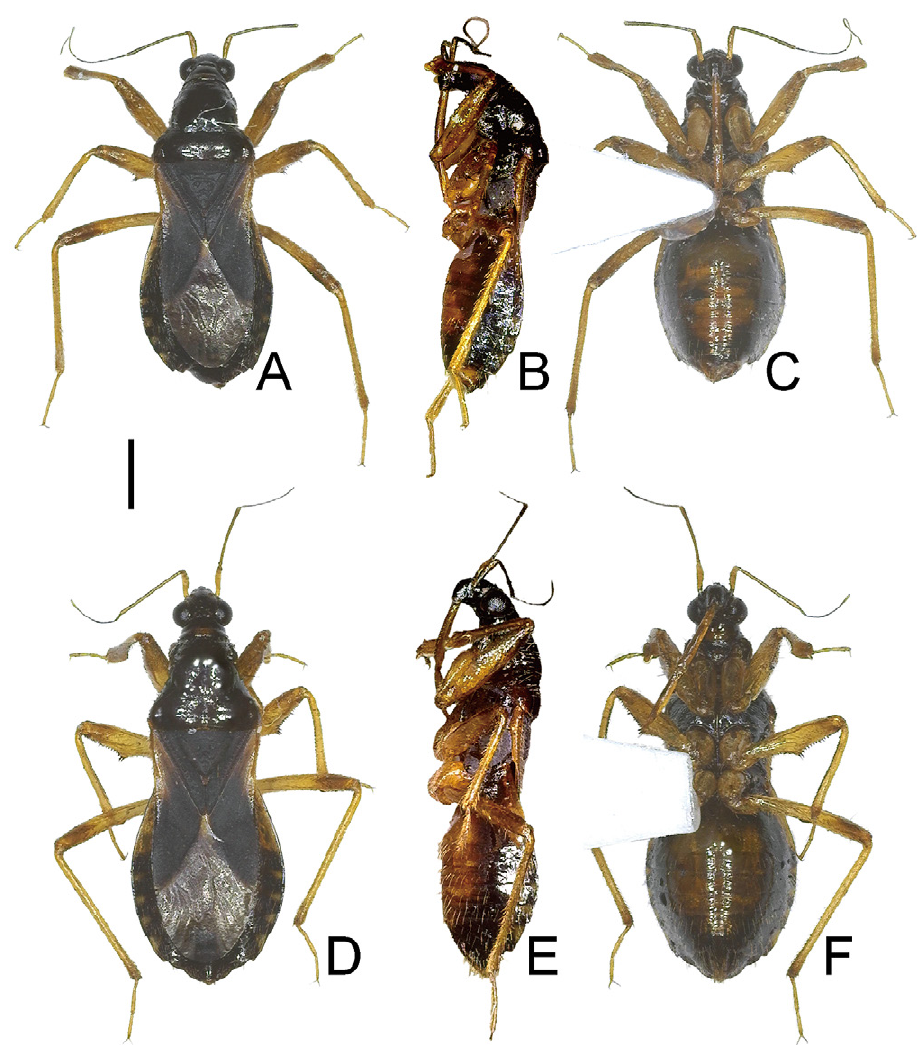
Figure 1. Dried specimens of Alloeorhynchus reinhardi from Fukuoka, Kyushu, Japan. A. Male, dorsal view. B. Male, lateral view. C. Male, ventral view. D. Female, dorsal view. E. Female, lateral view. F. Female, ventral view. Scale bar: 1.0